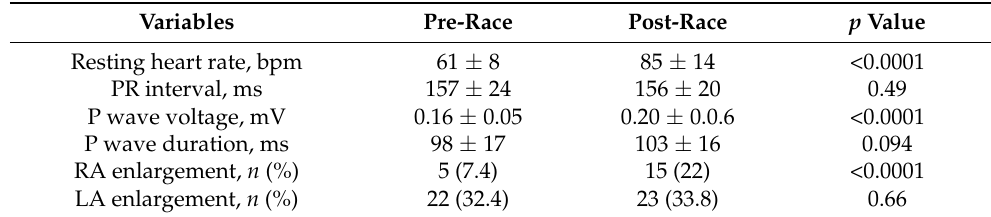
Table 2. Twelve-lead resting ECG data of atrial electrical remodelling, collected before and after the race, in master athletes running an